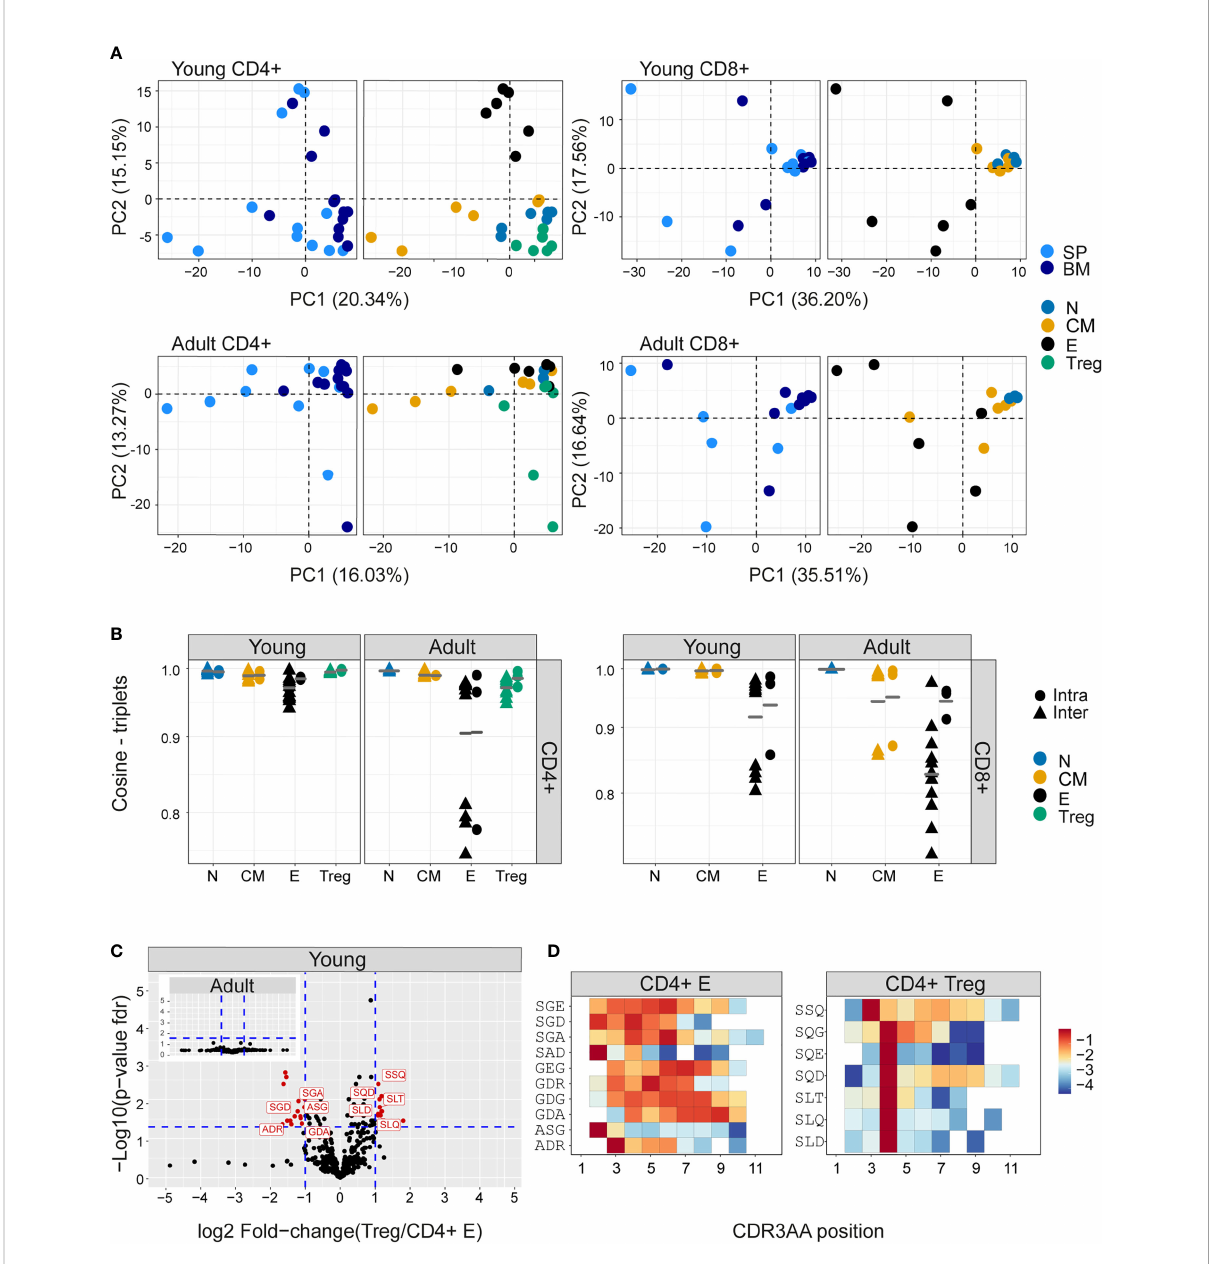
FIGURE 4 Differential frequency of amino acid motifs in TCR repertoires from different subpopulations. The most abundant amino acid triplets are selected by the mean frequency of each motif across all compartments and mice as described in materials and methods (A) PCA analysis of CDR3 b AA triplet frequency distributions for CD4+(left) or CD8+(right) from young (upper) or adult (lower) mice (e.g., CD8+ effectors, BM, mouse 1). (B) Cosine similarity between the frequency distributions of the 350 most abundant CDR3 b AA amino acid triplets between individuals (circles) or within individuals (between spleen and bone marrow, triangles). T cells compartments (colored dots) are divided into CD4+ (left) or CD8+ (right) from young or adult mice. Mean is shown by horizontal black lines. (C) Differentially expressed triplets in Treg and CD4+ effector from young and adult mice. Each dot represents a single triplet most 350 abundant or all 8000 triplets in red or black dots, respectively). P-value (t-test) was calculated for each triplet across six samples (three mice and 2 tissues) of CD4+ Treg and CD4+ effector cells. The y-axis shows FDR-adjusted p-values. The x-axis shows the log 2-fold-change, calculated between Treg and CD4+ effector mean triplets or motifs frequency across compartments (6 samples in each). Signi fi cance thresholds are marked in blue lines: (1) at y=1.3 (equivalent to p-value of 0.05) and x= ± 1 (denoting a total fold-change of 2). Representative triplets above both thresholds are labeled with red text and dots. (D) Signi fi cantly expressed triplets are found in various positions along the CDR3AA sequences. Triplets overexpressed in CD4+ Treg are frequently located in position 4 of the CDR3AAs (3 – 9). Triplets overexpressed in CD4 effector can be located mainly in position 2-3 or further along the CDR3AA sequences. The color represents the log10 frequency of each aligned